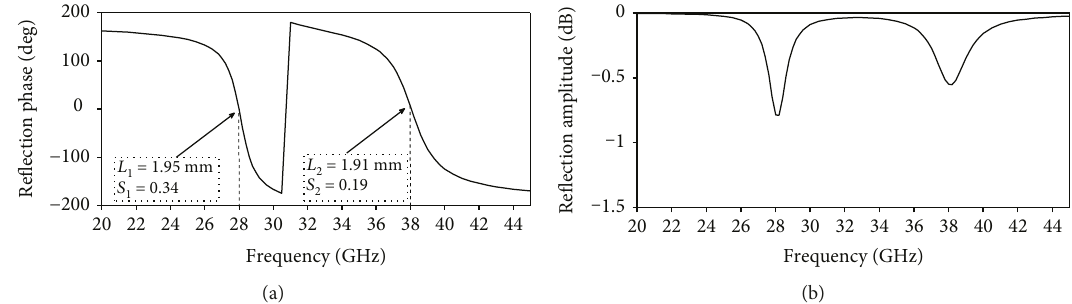
Figure 2: Simulated unit cell re fl ection coe ffi cient vs. frequency: (a) phase and (b)